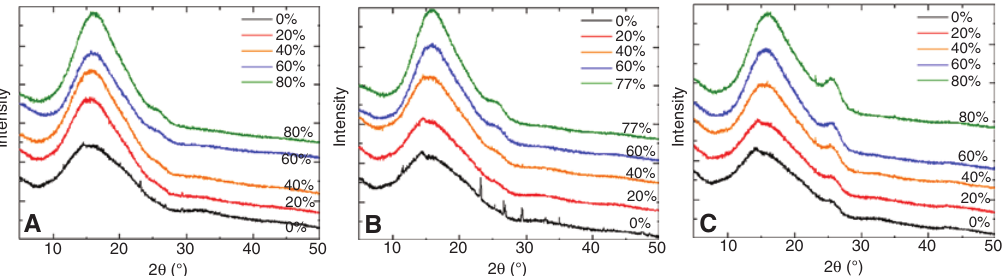
Figure 2: X-ray diffraction curves of composites with (A) 3wt.%, (B) 5wt.%, and (C) 10wt.% MWCNTs at various rolling